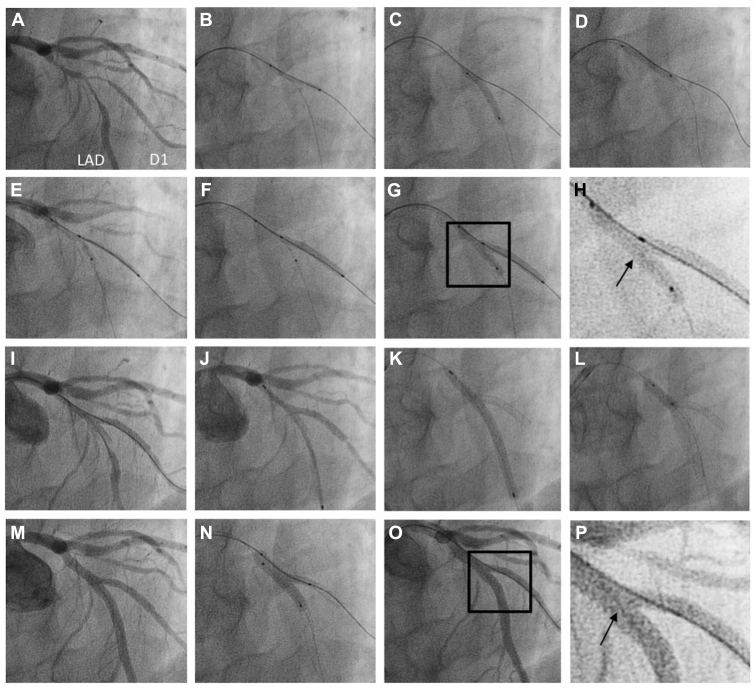
(A) An example of the double-kissing nanocrush technique in a 66-year-old patient with severe disease at the left anterior descending coronary artery (LAD)/diagonal (D) 1 bifurcation. (B-D) Both vessels were wired and then predilated. (E) A 2.5 × 20-mm Promus Premier (Boston Scientific) stent was positioned in D1 with a 2.5-mm balloon (the one used to predilate the LAD) in the main branch (MB). Care was taken to ensure that the proximal end of the side branch (SB) stent was precisely positioned at the take-off of the SB. (F) The SB stent was deployed. (G, H) The MB balloon was inflated, the SB balloon was pulled back, and a kissing inflation was performed. (I) Angiography demonstrated patency of both vessels. A 3 × 48-mm Xience (Abbott) stent was (J) positioned and (K) deployed in the MB. (L) Proximal optimisation was performed with a 3.5 × 12-mm balloon with (M) a good angiographic result. (N) The SB was rewired through the proximal part of the SB ostium and a final kissing inflation was performed with 3.0- and 2.5-mm balloons with (O) an excellent angiographic result and (P) a short neocarina.